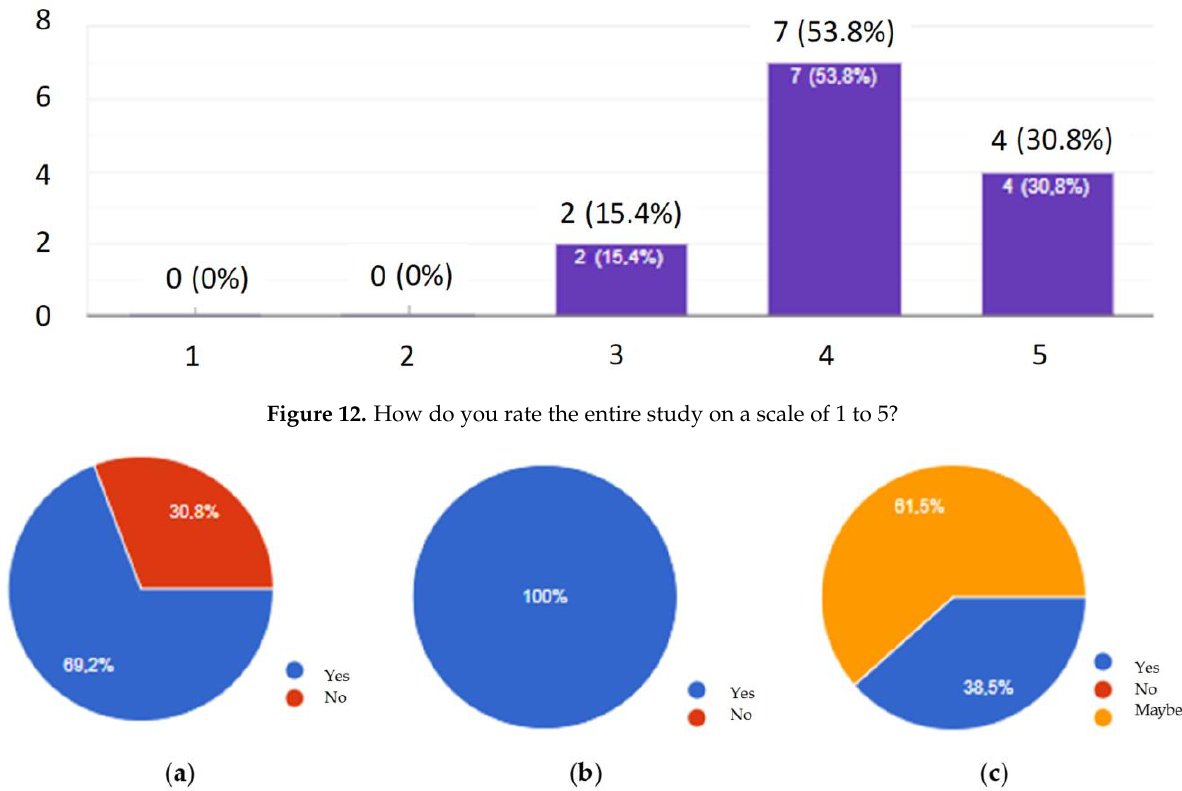
Figure 13. ( a ) Have you gained more knowledge about conveyor belts? ( b ) Was previously acquired knowledge consolidated? ( c ) Would you agree to take part in the study again?